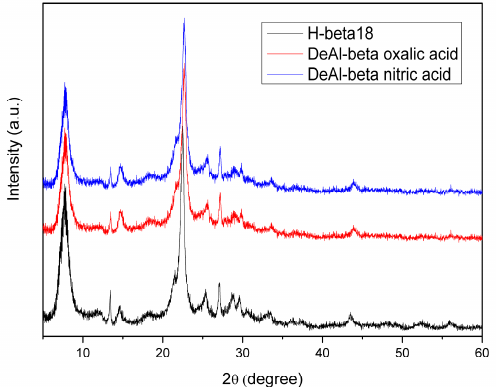
Figure 2. X-ray diffraction patterns of H- β 18 and the corresponding dealuminated samples (DeAl-Beta). Treatment in nitric (blue) and oxalic acid (red), respectively.